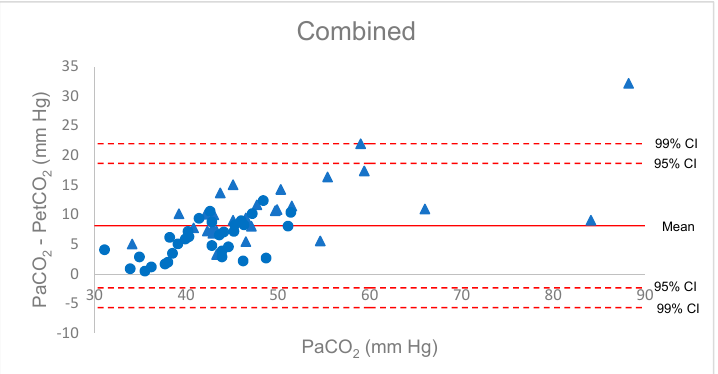
Figure 1. Bland–Altman diagram for the P(a-et)CO 2 gradient, combined group. Red triangles: COVID patients; blue circles: anaesthesia patients.